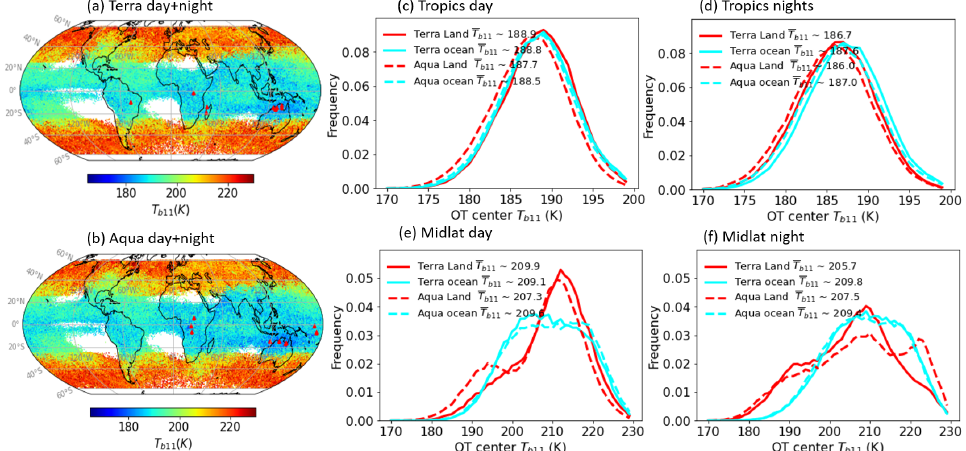
Figure 11. Panels (a) and (b) are for spatial distributions of the OT center T b11 . Red triangles indicate the locations of top 10 coldest OTs. Panels (c) – (f) are for the OT center T b11 probability density distributions (PDFs) in the tropics and midlatitudes and are segregated into daytime and nighttime